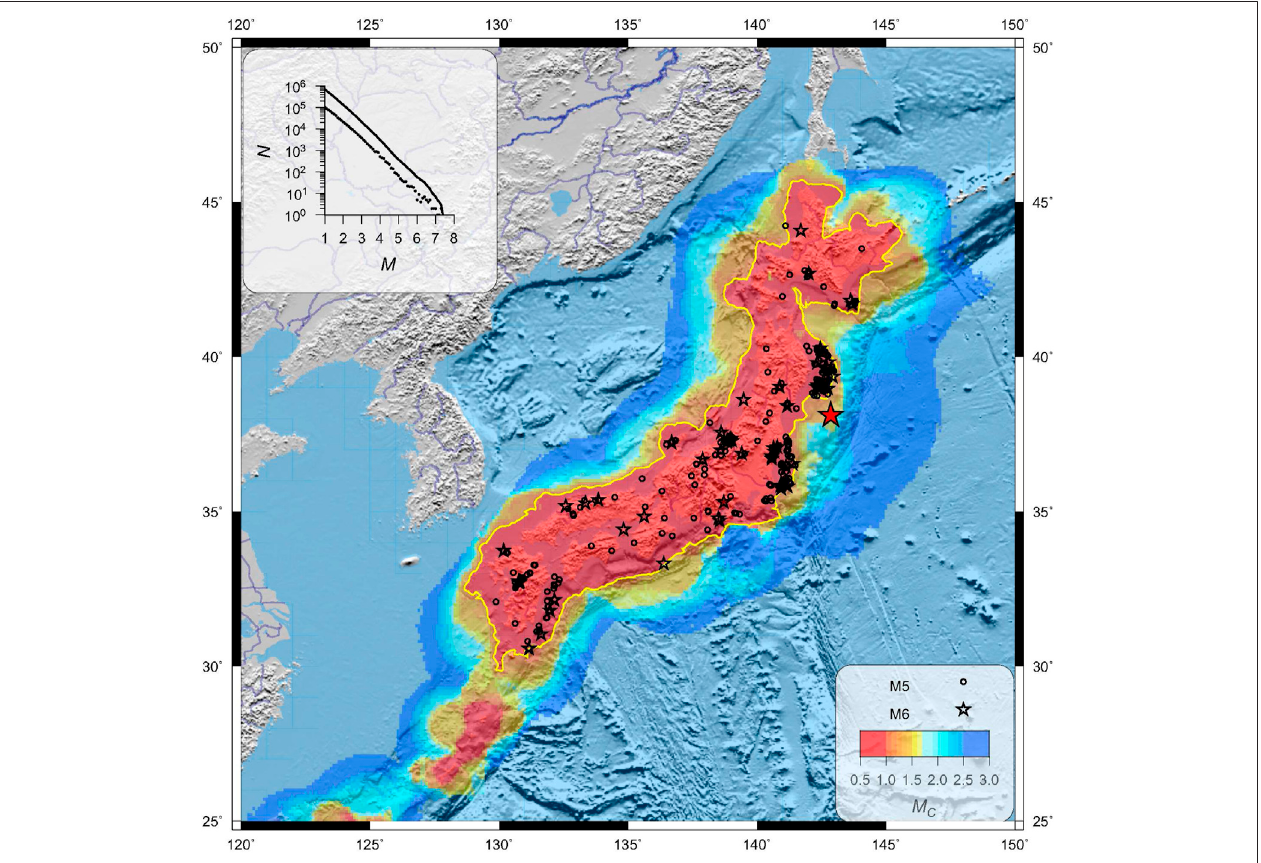
FIGURE 1 | Map of the completeness magnitude M c for the land part of Japan. The yellow line outlines the area of M c ≤ 1. Epicenters of the earthquakes (parent events)weusedintheanalysisoftheproductivityareshownbycircles(5 ≤ M < 6)andstars( M ≥ 6).RedstarshowstheepicenteroftheTohokuearthquakeof11March 2011, M w = 9.1. Tab at the top shows the frequency-magnitude distribution of earthquakes within the area of M c ≤